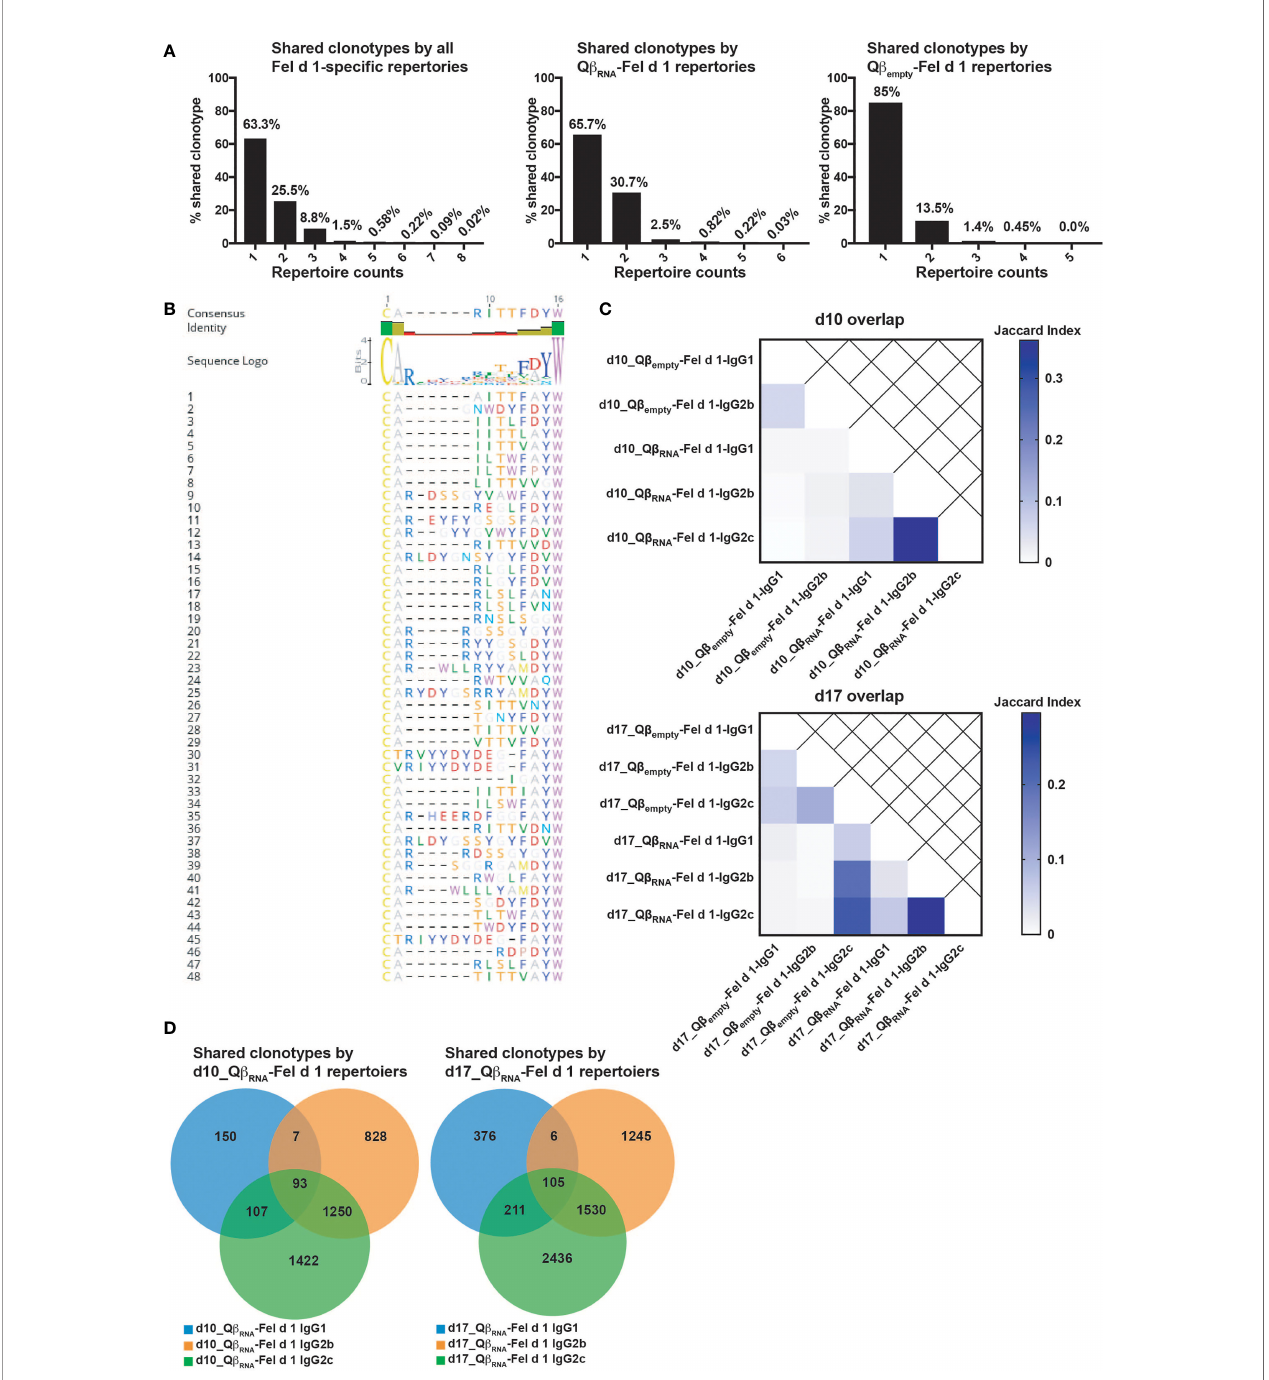
FIGURE 6 | Shared CDR3 clonotypes among Fel d 1-speci fi c BCR repertoires. (A) Percentage of CDR3 sequences shared by different samples of all obtained BCR repertories, RNA-adjuvanted repertoires and non-RNA adjuvanted repertoires; (B) Alignment of top 48 CDR3 sequences that shared by more than 6 samples. The consensus sequence was acquired by Geneious Prime; (C) Jaccard indexes of overlapped CDR3 clonotypes among BCR repertoires at d10 or d17 after immunization; (D) Venn-diagrams of shared CDR3 clonotypes among IgG isotype repertoires at d10 or d17 after Q b RNA -Fel d 1 immunization. The fi gure is representative of two independent